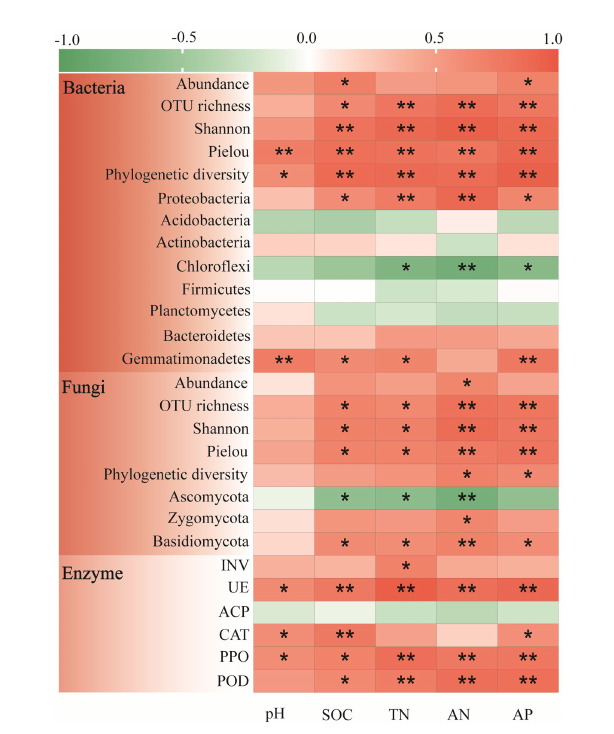
FIGURE 2 Pearson correlation analysis of soil fertility indexes with microbial community composition (abundance, alpha-diversity and dominant phyla) and enzyme activities in the Cinnamomum camphora coppice planting. Red represents a positive correlation, and green represents a negative correlation. (* p < 0.05; ** p <